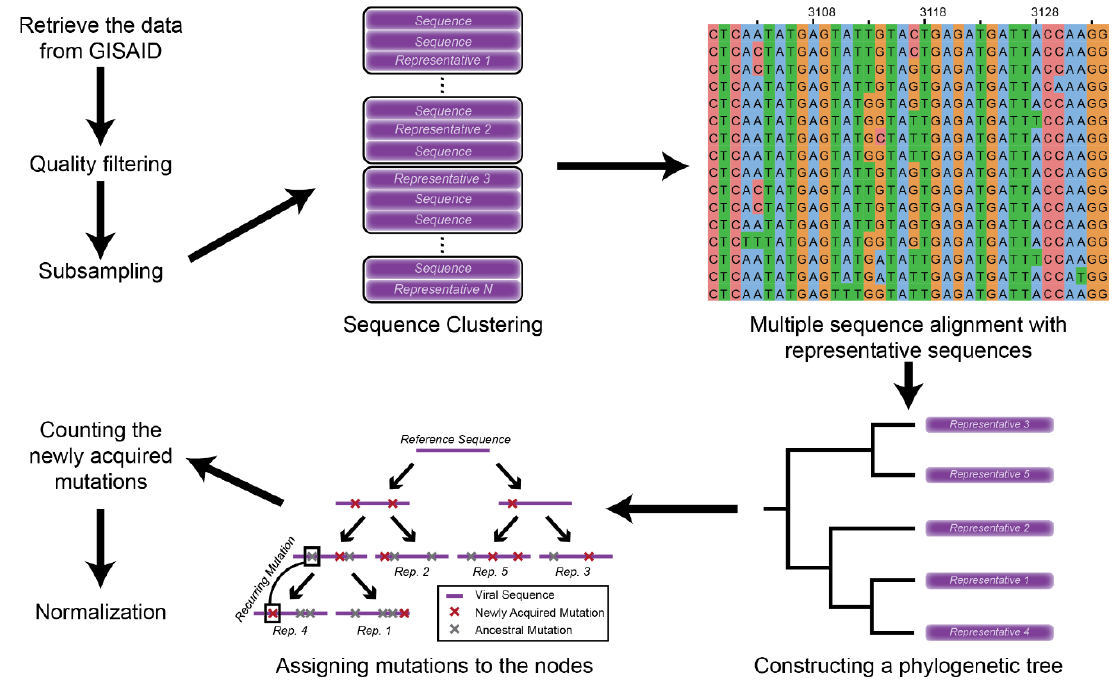
Figure 1. Schematic representation of the methodology.